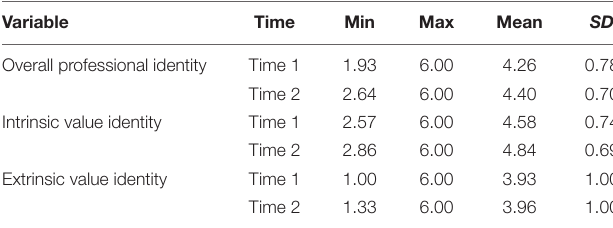
TABLE 2 | Descriptive statistics of sub-dimensions and overall construct ( n =